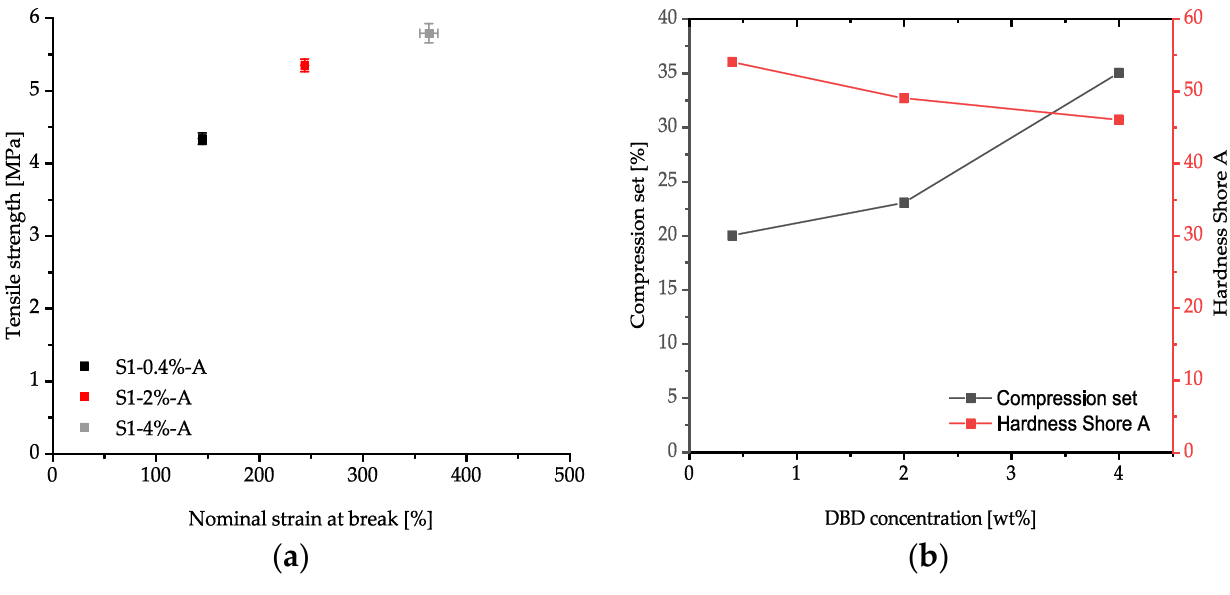
Figure 2. Tensile strength and nominal strain at break ( a ) and compression set and hardness Shore A ( b ) of S1-0.4%-A, S1-2%-A, and S1-4%-A.